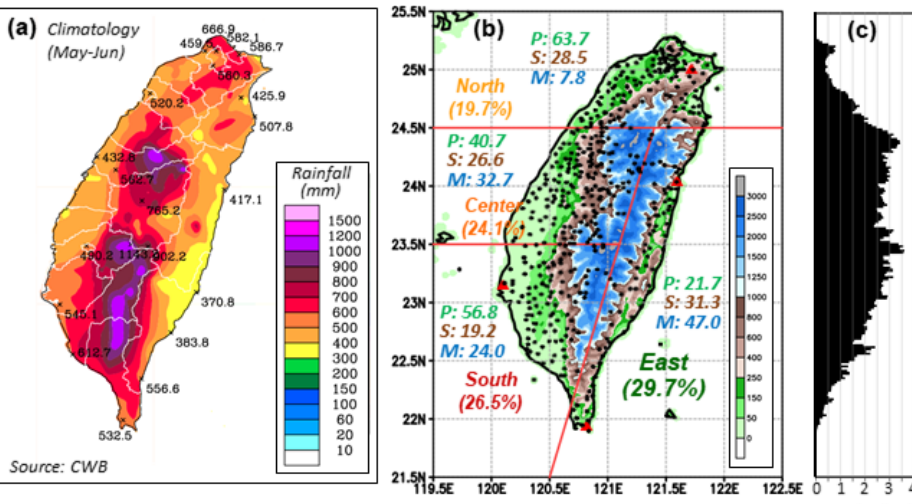
Figure 2. (a) The distribution of total accumulated rainfall (mm) per Mei-yu season (May–June) in the climatology of 1981–2010 (source: CWB). (b) The topography (m, color) of Taiwan and locations of rain gauge sites in 2013 (dots). The three elevation ranges of plain ( < 250m), slope (0.25–1km), and mountain ( ≥ 1km) and the four subregions of Taiwan (north, center, south, and east), as well as (c) the north–south profile of the highest topography (km). In (b) , the parentheses give the percentage (%) of each subregion in Taiwan, while the percentages of the three elevation ranges (P, S, and M) in each subregion are also labeled. The four red triangles mark the locations of land-based radars used to produce the composites and rainfall estimates shown in Figs. 11–13. Table 1. The methods used to construct the idealized wind and moisture profiles (at the reference point of 23.5 ◦ N, 120.5 ◦ E) in this study. Wind profile in the vertical for a prescribed southwesterly flow 950–500hPa At 300hPa and above Fixed at the modified sounding (Fig. 3f and g, same for all runs) 500–300hPa Linearly interpolated between winds at 500 and 300hPa Surface to 950hPa Linearly reduced (from 950hPa) to half the speed and 15 ◦ to the left at the surface Moisture profile in the vertical for a prescribed near-surface RH value Surface to 950hPa Fixed at the prescribed RH value (e.g., 85%) Fixed at 40% (as in Fig. 3h, same for all runs) Linearly interpolated between RH values at 950 and